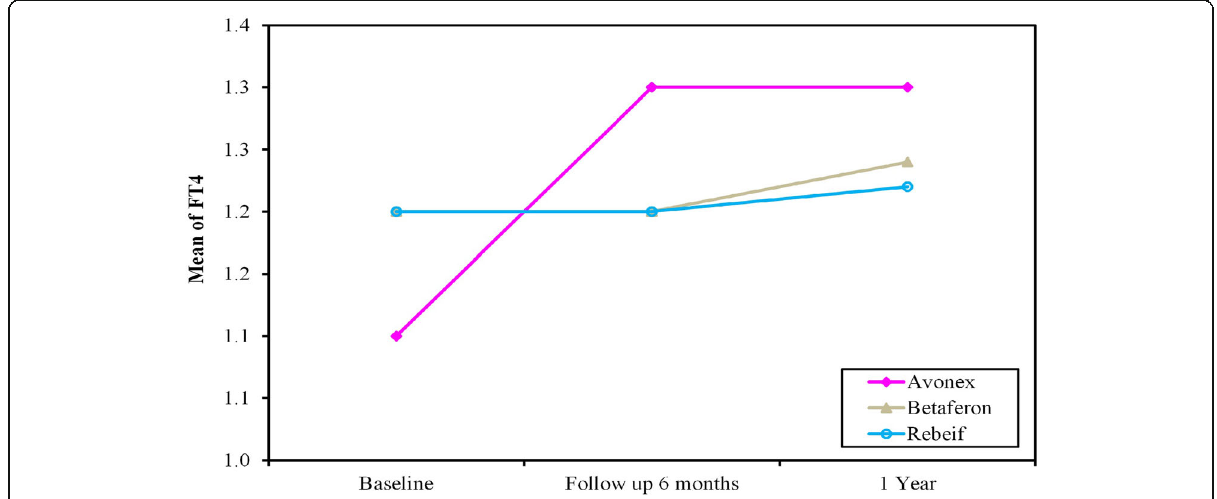
Fig. 5 Comparison between each separate drug groups at baseline, 6-, and 12-month follow-up periods according to